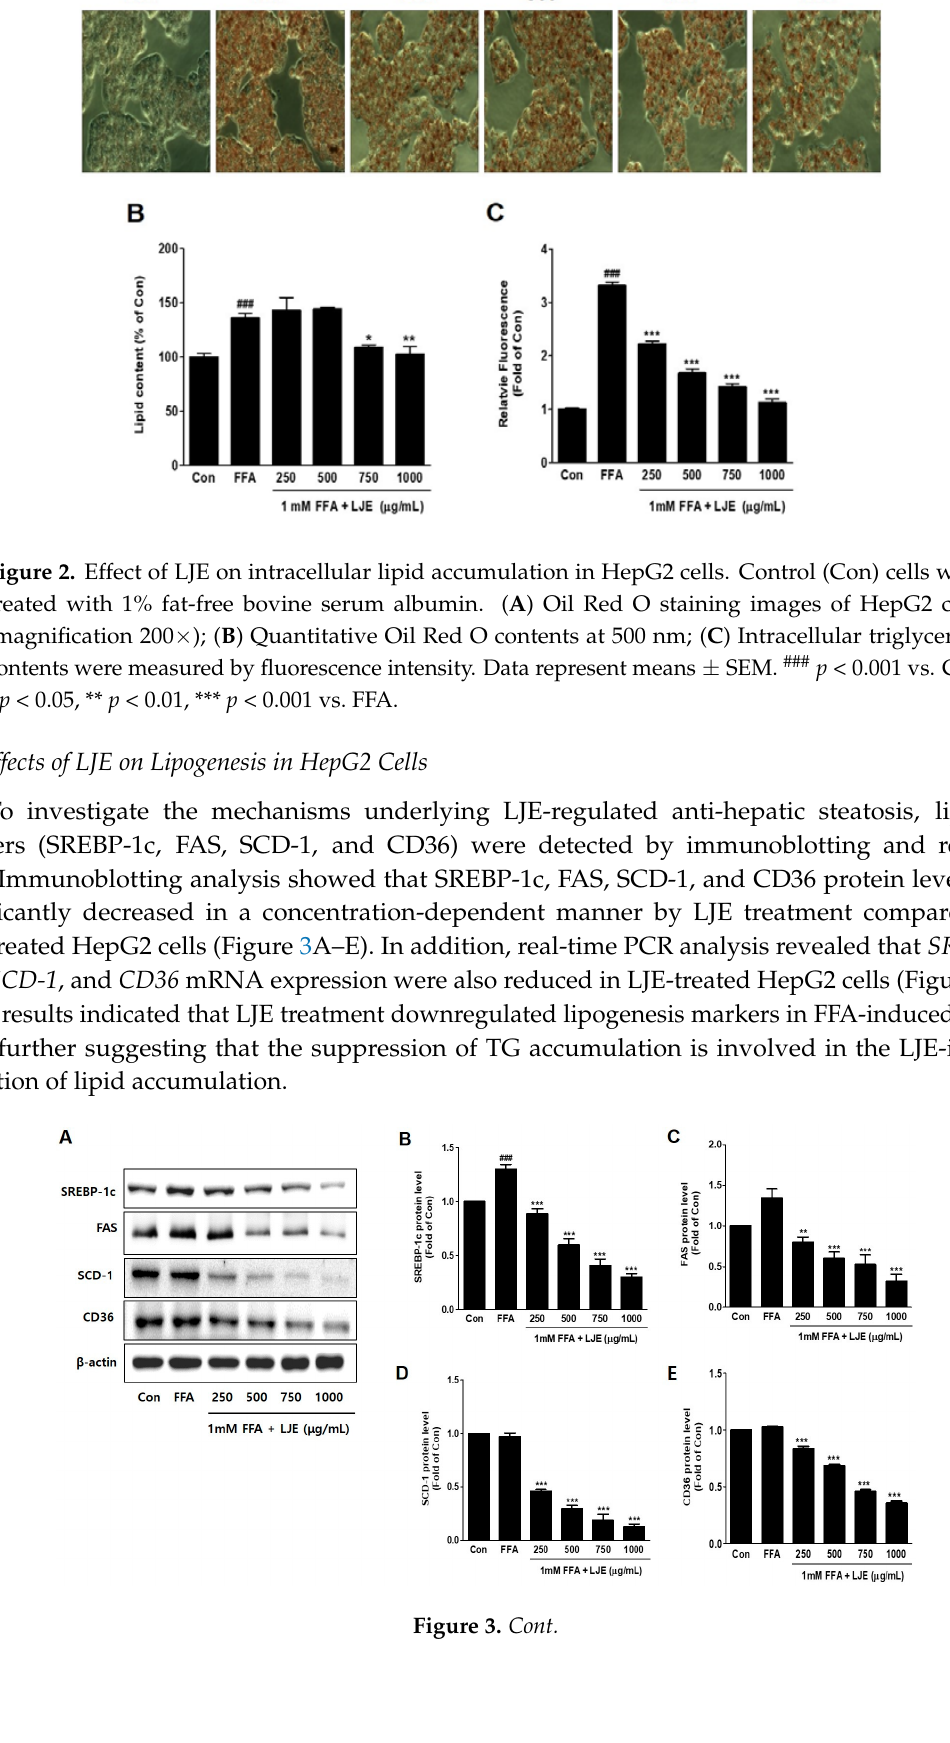
Figure 3. Effects of LJE on lipogenesis markers in HepG2 cells. ( A – E ) Immunoblot analysis; ( F – I ) Quantitative real-time PCR analysis. Data represent means ± SEM. # p < 0.05, ## p < 0.01, ### p < 0.001 vs. Con; ** p < 0.01, *** p < 0.001 vs. FFA. 3.4. Effects of LJE on Phosphorylation of AMP-activated Protein Kinase (AMPK) and Acetyl-CoA Carboxylase (ACC) and mRNA Expression of PPAR α and CPT-1 in HepG2 Cells LJE significantly increased the phosphorylation of AMPK and ACC, which is the direct substrate of AMPK (Figure 4A–C). PPAR- α and CPT1 mRNA levels (related to β -oxidation) were also significantly increased by LJE treatment in FFA-induced HepG2 cells (Figure 4D,E). Figure 4. Effects of LJE on the phosphorylation of AMP-activated protein kinase (AMPK) and acetyl- CoA carboxylase (ACC) and the mRNA expression of fatty acid oxidation factors in HepG2 cells. ( A –